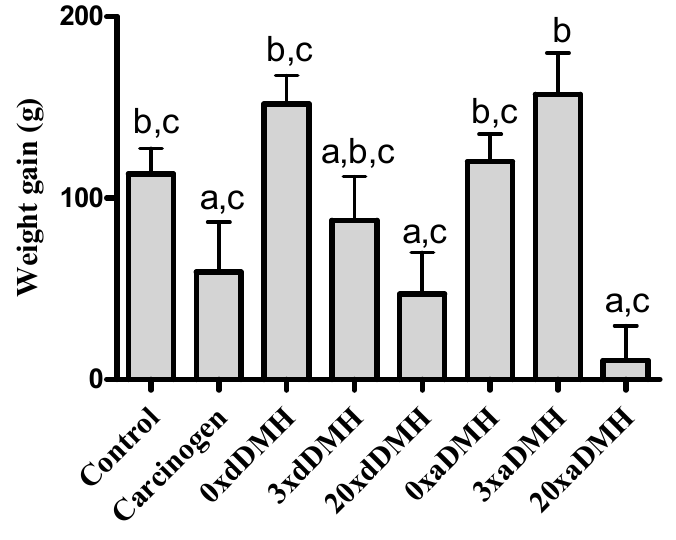
Figure 3. Mean weight gain (g) at the end of the experiment. Bar values with the same superscript letters are not significantly different.